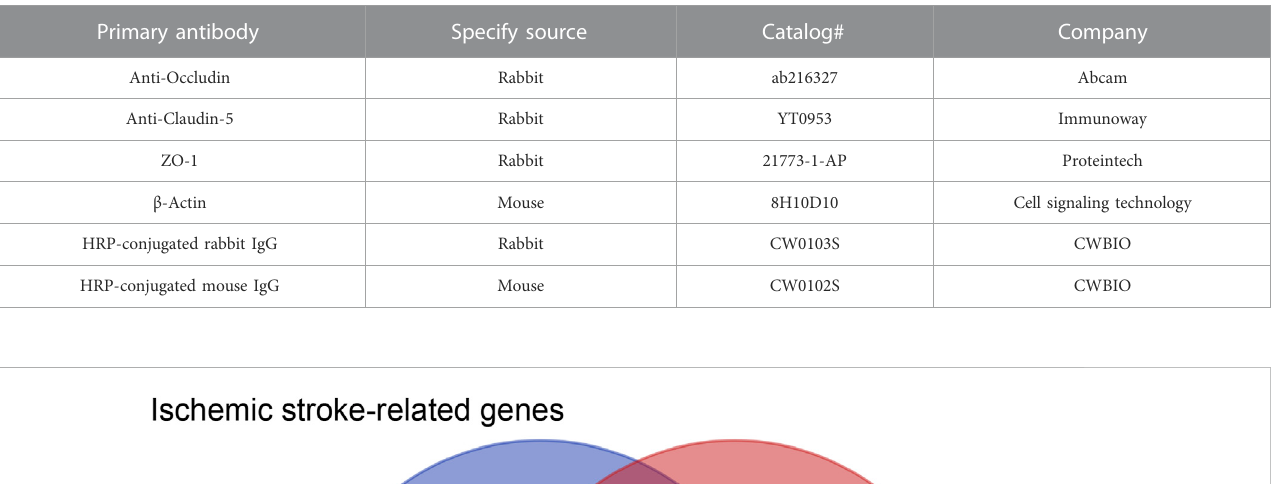
TABLE 2 Antibodies and the